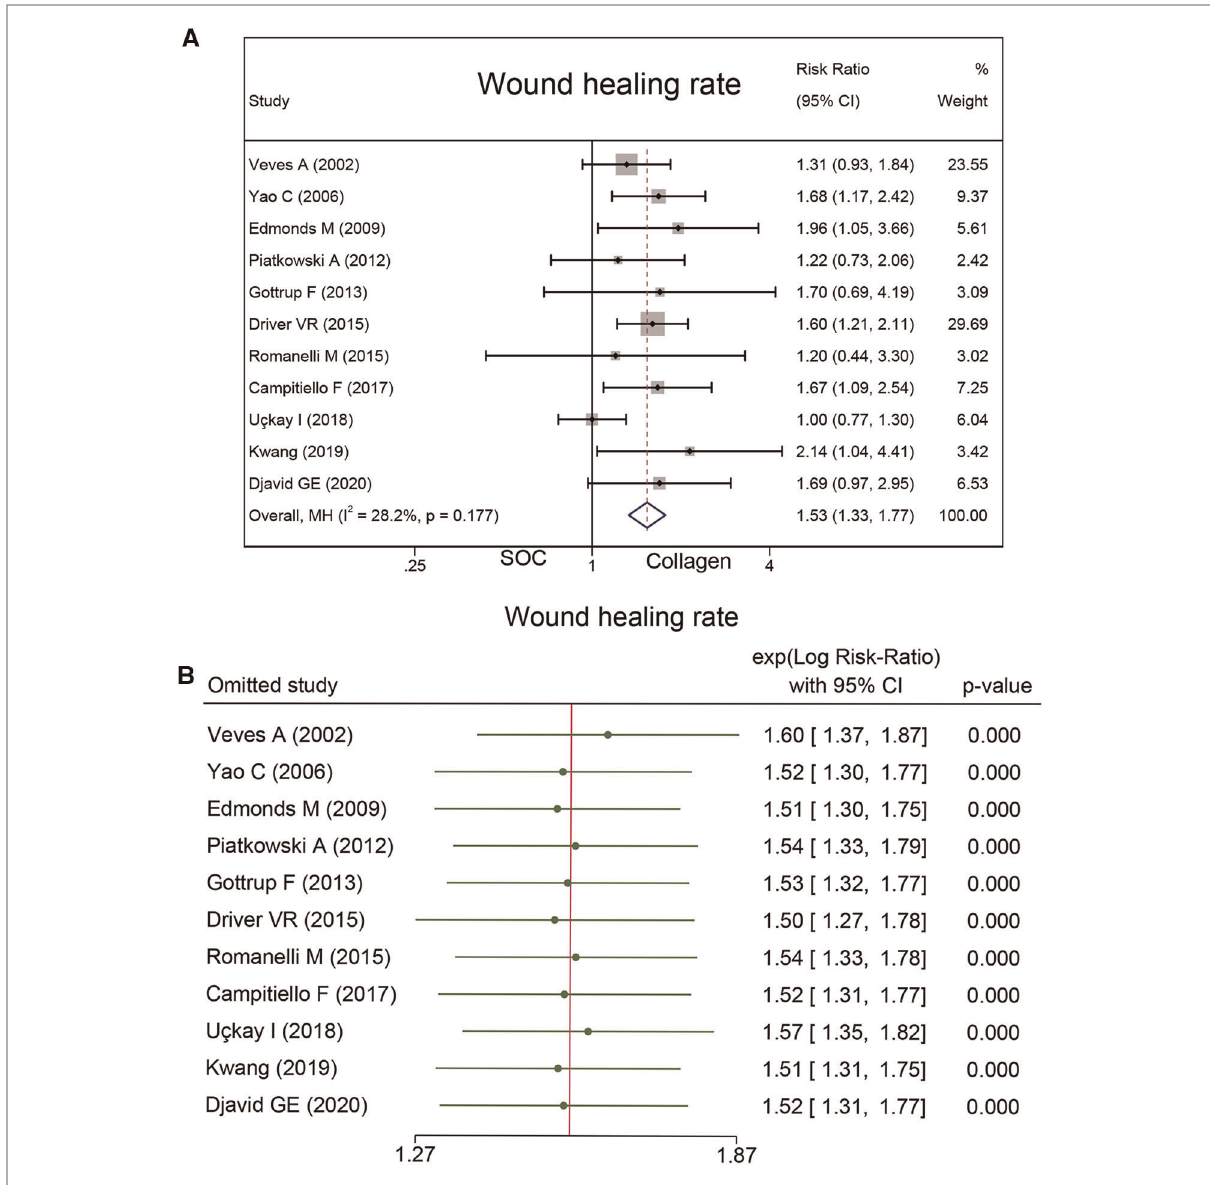
FIGURE 4 Wound healing rate: ( A ) the pooled result; ( B ) sensitivity